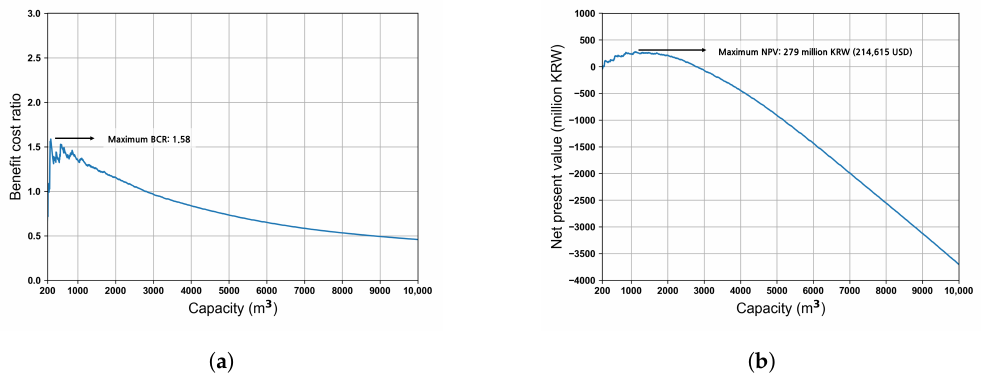
Figure 8. The results of the cost–benefit analysis of the considered rainwater harvesting system without financial support programs: ( a ) the capacity–BCR curve; ( b ) the capacity–NPV